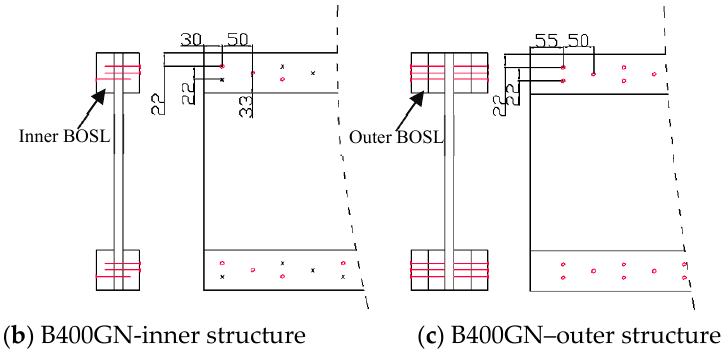
Figure 1. Details of I-beam: ( a ) I-beam cross section; ( b ) side and front view of the inner BOSL connection type in B400GN; ( c ) side and front view of the outer BOSL connection type in B400GN.